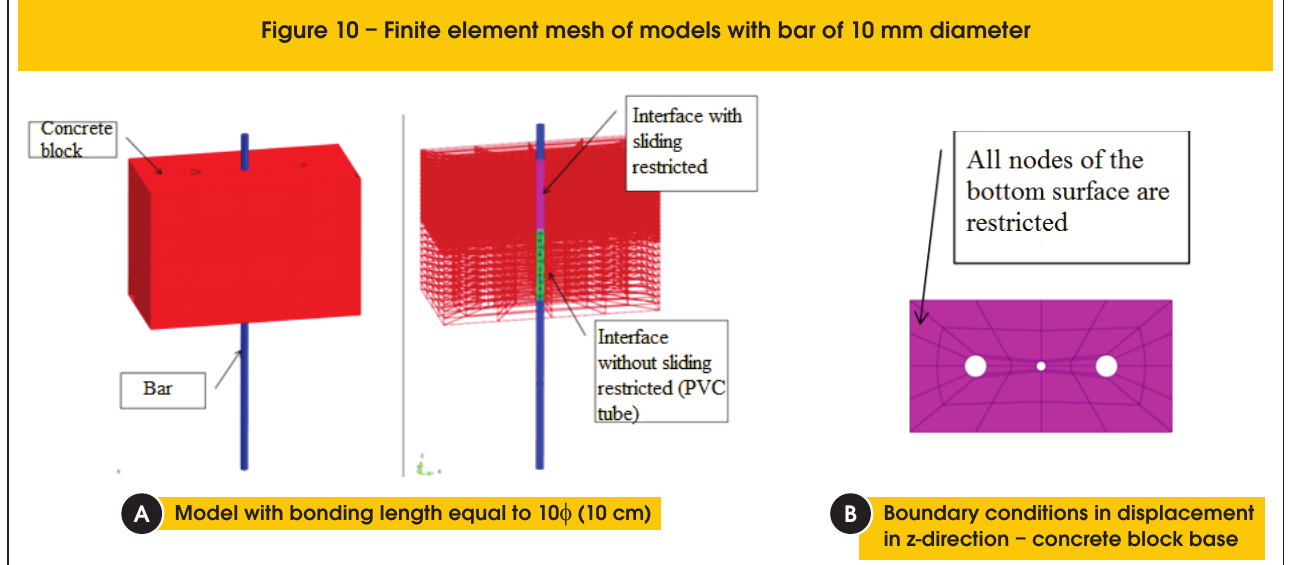
Figure 10 – Finite element mesh of models with bar of 10 mm diameter